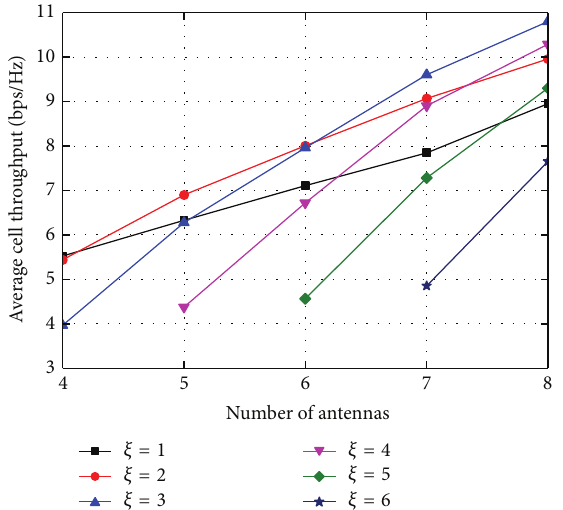
Figure8:CellthroughputforDUSIAwithdifferent 𝜉 versusnumber of antennas. Cell edge SNR = 20